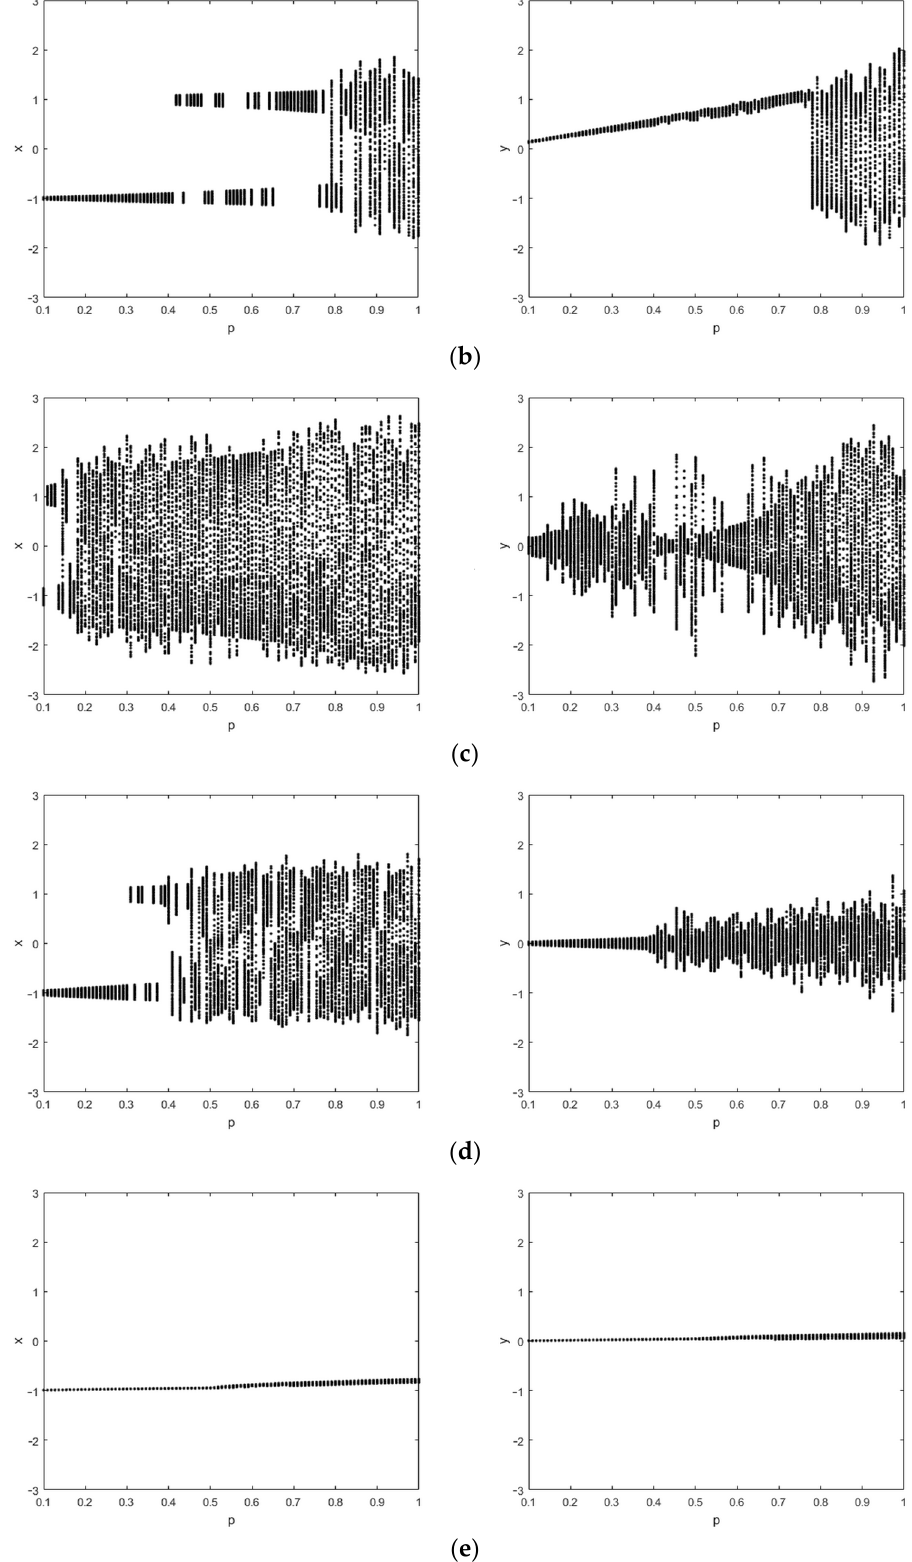
Figure 6. Bifurcation of the vibration absorber (on the left side) and the main system (on the right side) along excitation amplitude at different excitation frequencies. ( a ) Excitation frequency ω = 0.1; ( b ) Excitation frequency ω = 0.5; ( c ) Excitation frequency ω = 1; ( d ) Excitation frequency ω = 2; ( e ) Excitation frequency ω = 3.5.